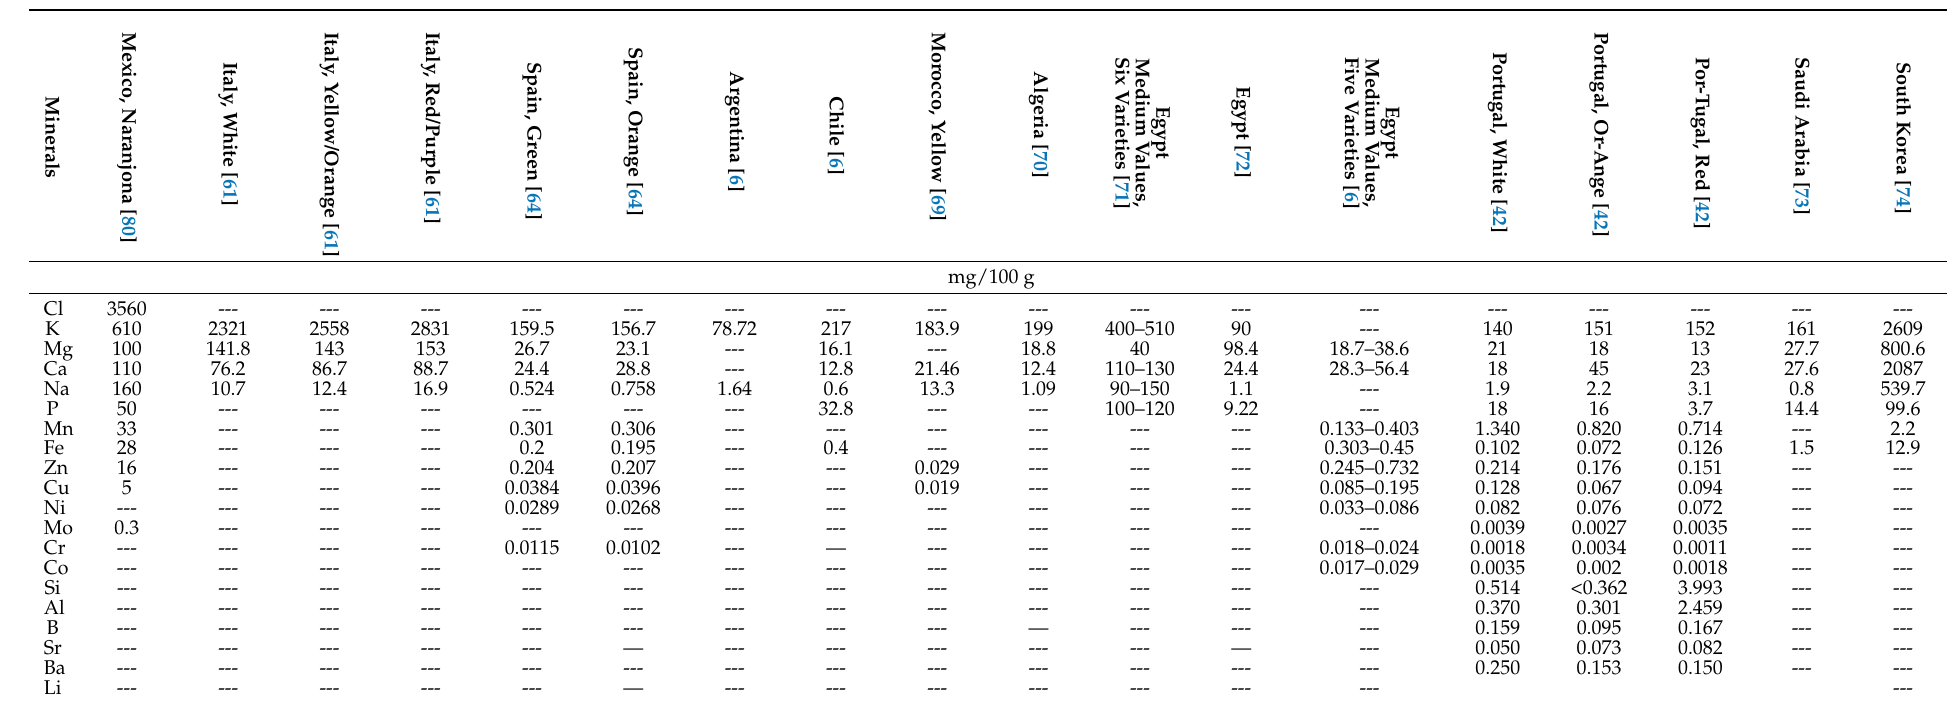
Table 4. Mineral composition of several PP ecotypes in different regions of the